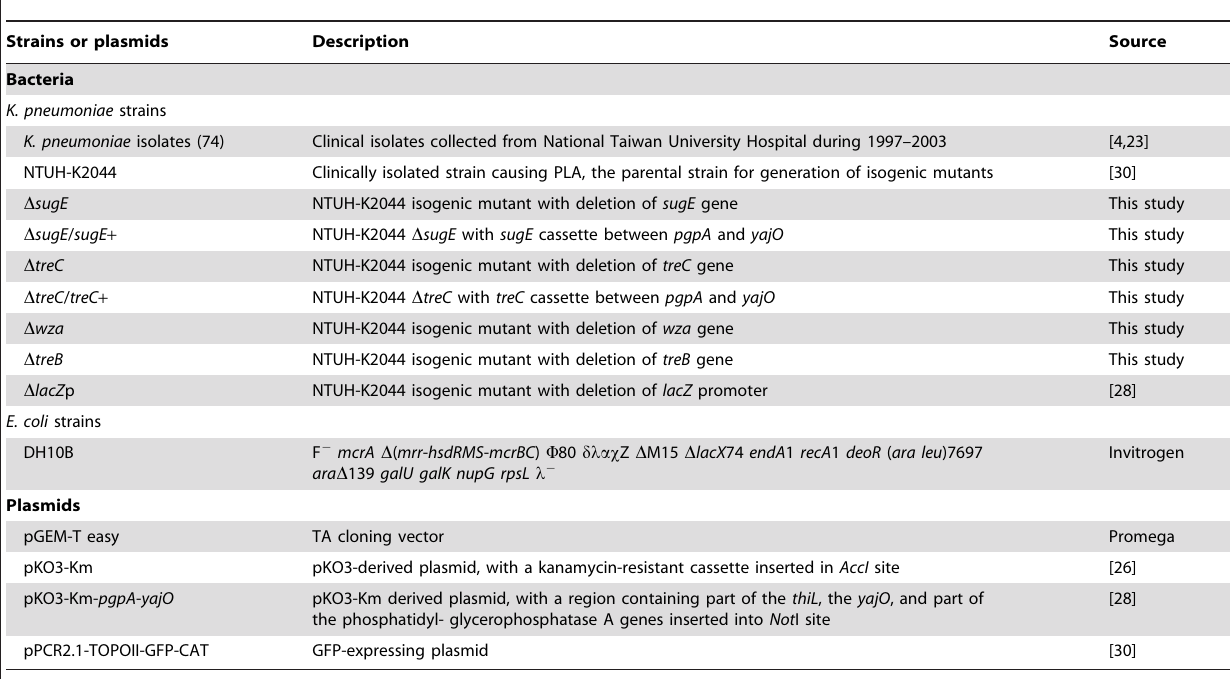
Table 1. Bacterial strains and plasmids used in this